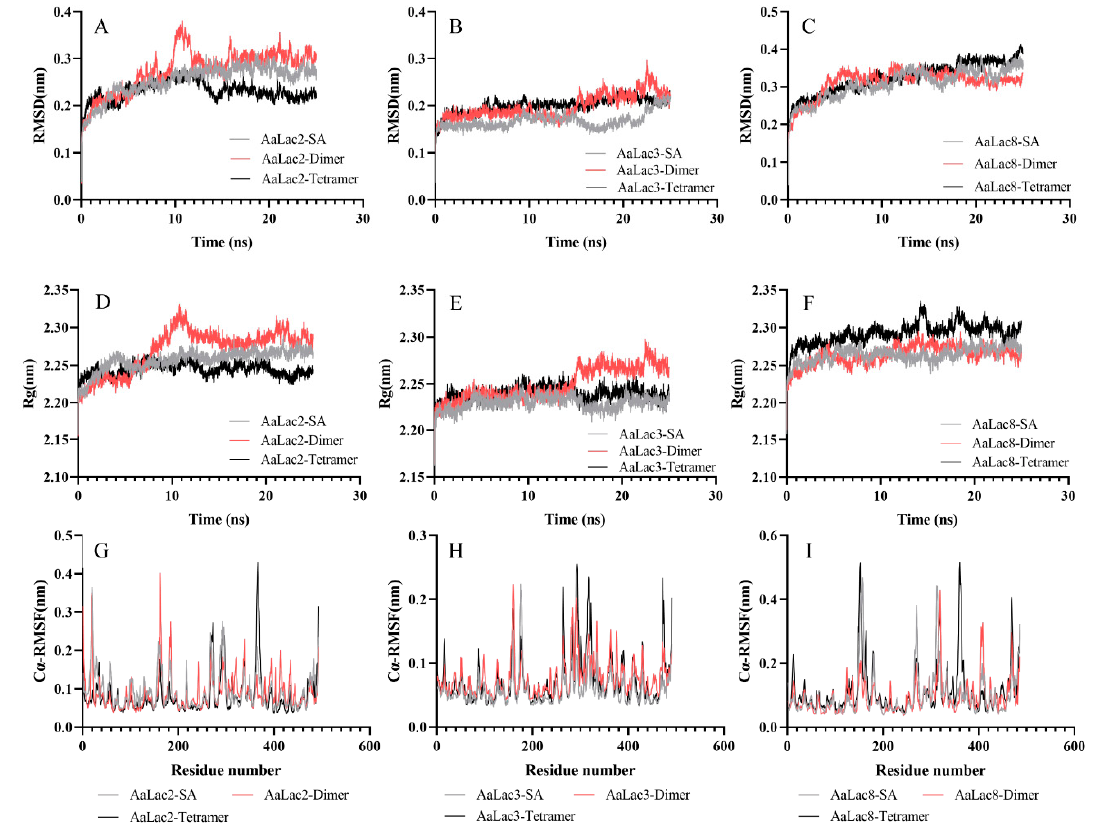
Figure 7. The variation of ( A – C ) root mean square (RMSD), ( D – F ) radius of gyration (Rg) and ( G – I ) root mean square fluctuation (RMSF) for AaLac2-SA, AaLac2-dimer, AaLac2-tetramer, AaLac3-SA, AaLac3-dimer, AaLac3-tetramer, AaLac8-SA, AaLac8-dimer, and AaLac8-tetramer.